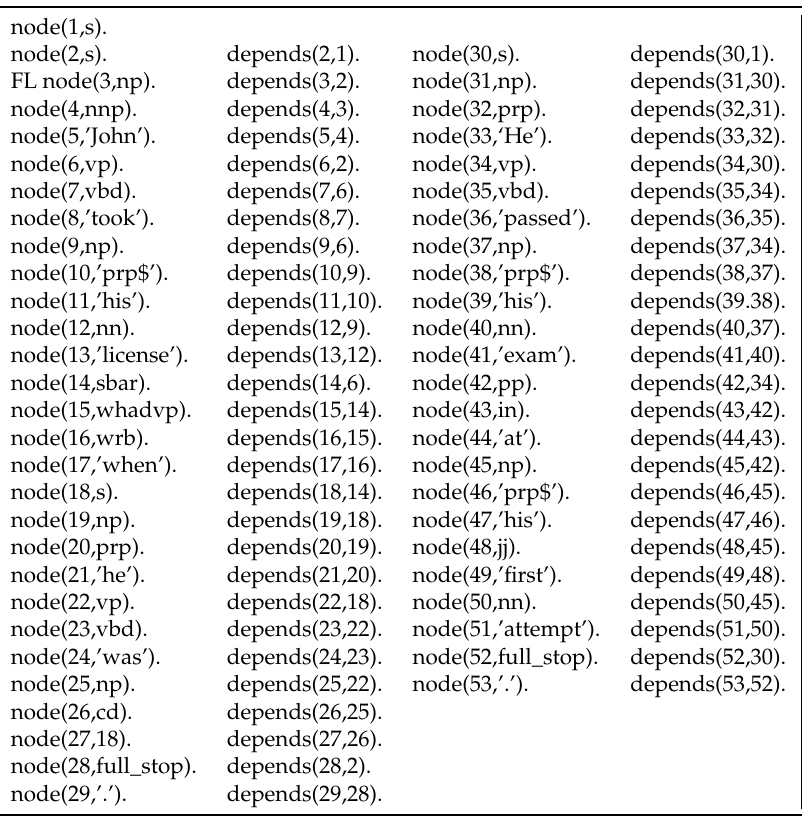
Figure 2. First-Order Logic facts expressing the parse tree of sample